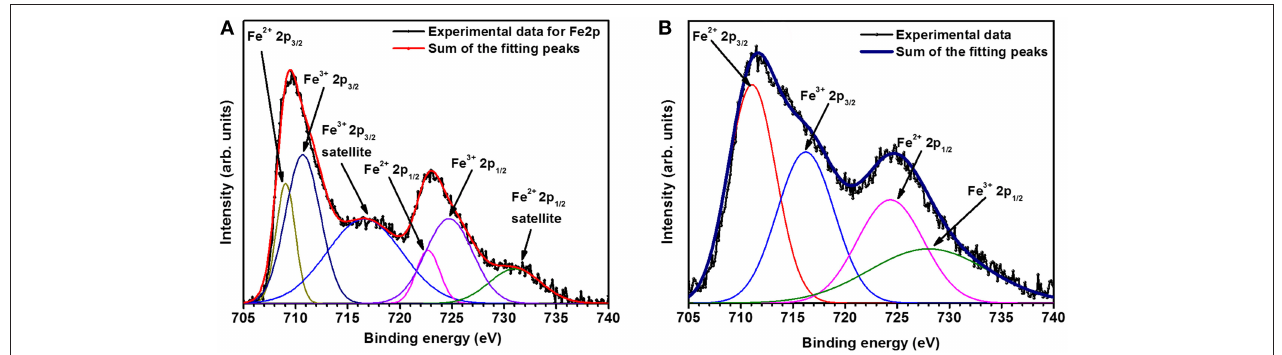
FIGURE 9 | XPS spectra for Fe present in (A) Fe 2 O 3 and (B) NaFePO 4 .